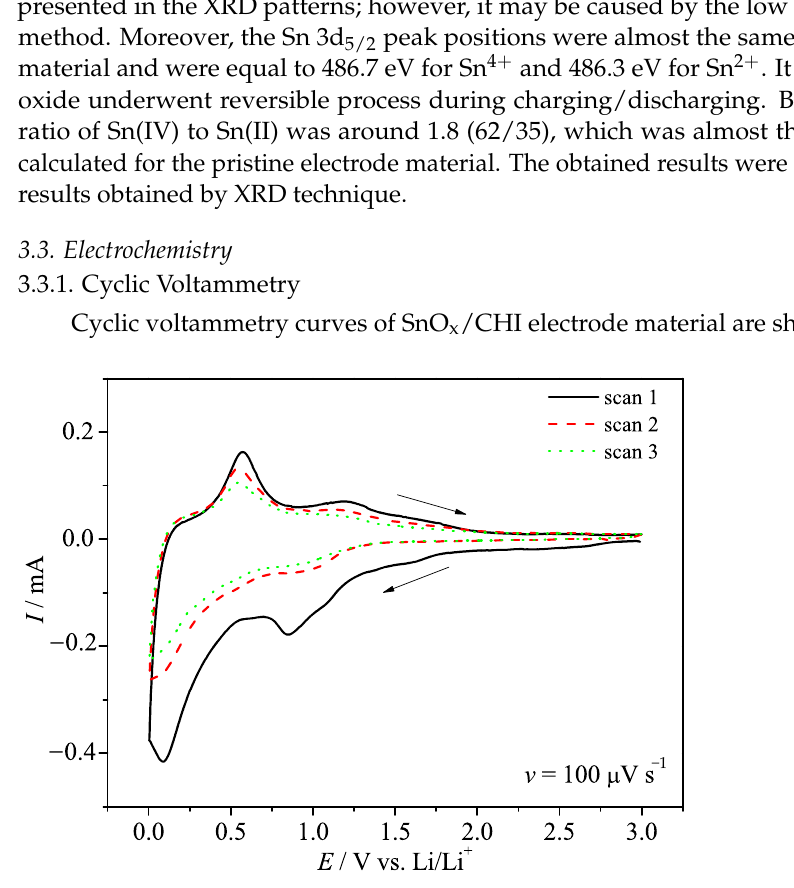
Figure 3. Cyclic voltammetry curves of SnO x /CHI electrode in LP30 at a sweep rate of v = 100 µ V s − 1 in the potential range 0.005–3.0 V versus Li/Li +